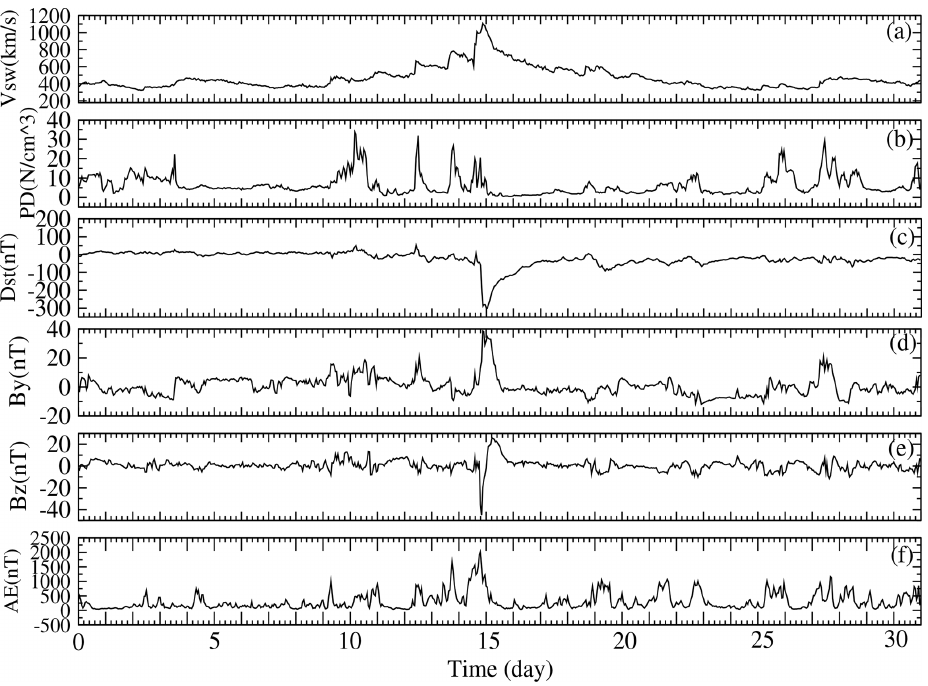
Figure 3. The 1h averaged variations in V sw , PD, Dst, IMF B y and B z and AE for the geomagnetically quiet solar minimum